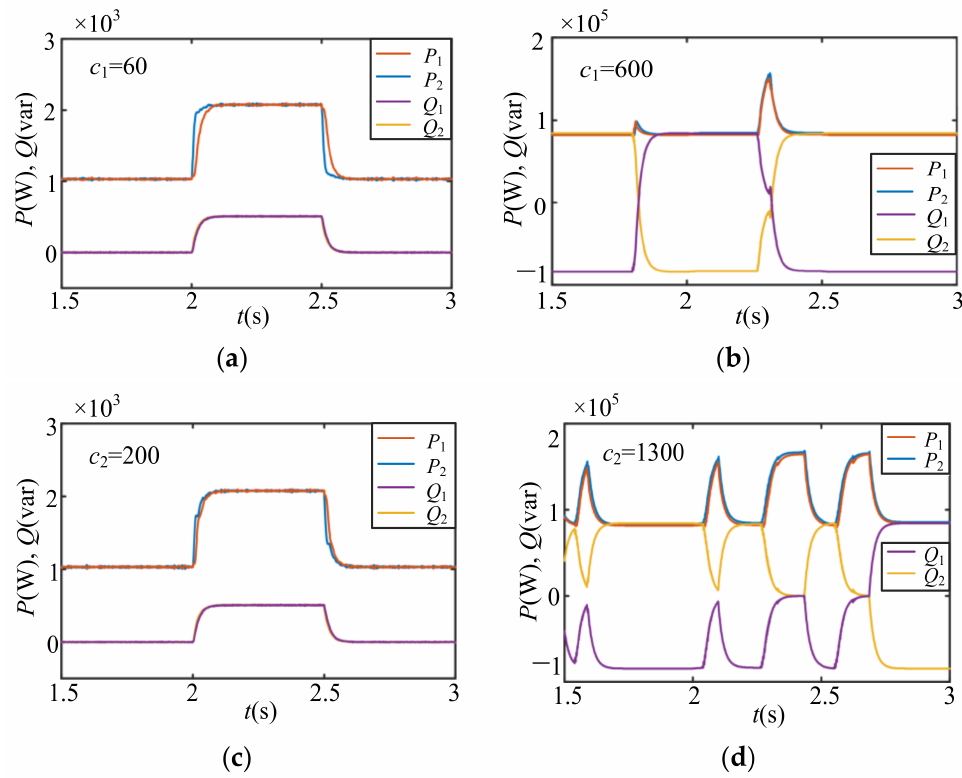
Figure 9. Power response at different parameter values ( c 1 and c 2 ) of proposed TSMC-based P-U/Q-f droop controller: ( a ) c 1 = 60 and c 2 = 500; ( b ) c 1 = 600 and c 2 = 500; ( c ) c 1 = 300 and c 2 =200; ( d ) c 1 = 300 and c 2 =